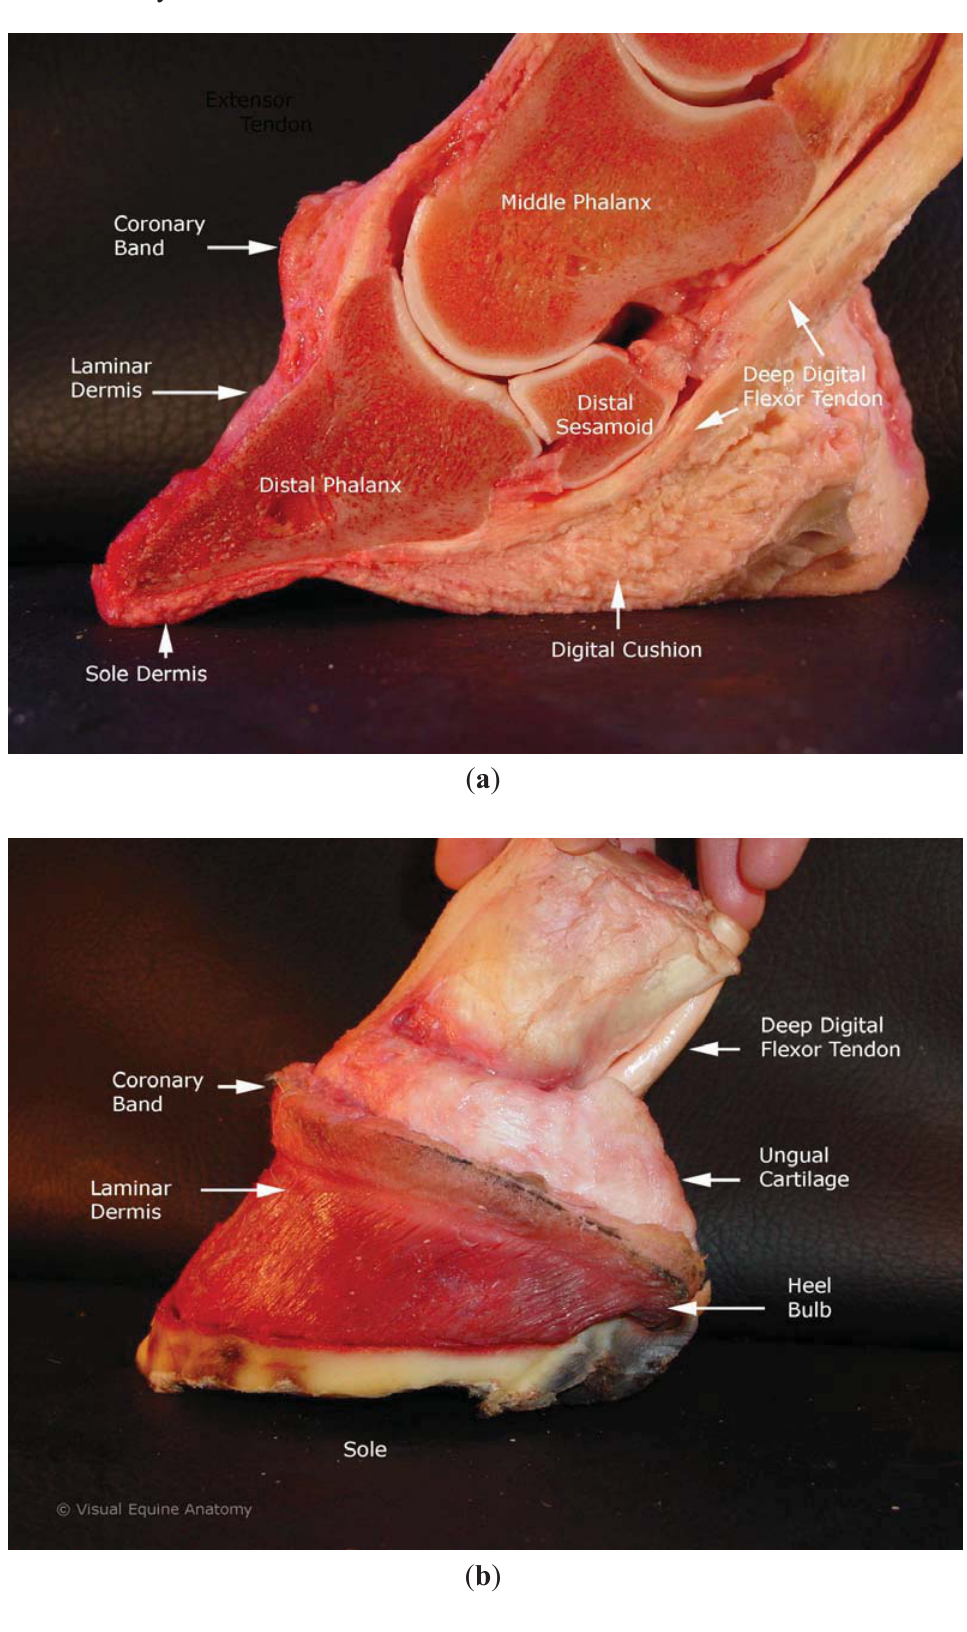
Figure 1. ( a ) Equine foot specimen sagittal section with hoof capsule removed. Labels identify structures likely to be influenced by acupuncture needles in coronet and nerve block point locations. ( b ) Equine foot specimen with hoof capsule and skin removed, laminar and coronary dermis left